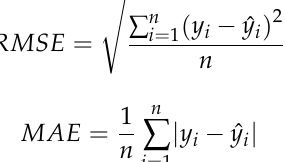
model performance: (1) Pearson correlation coefficient ( r ) between the observed values